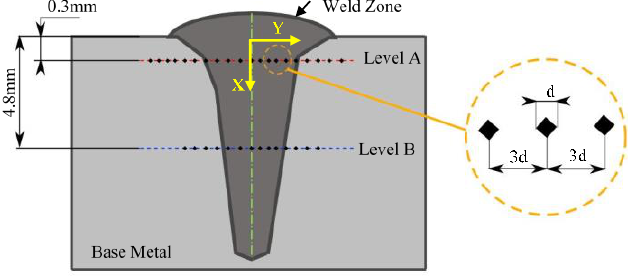
Figure 6: Microhardness testing across a typical